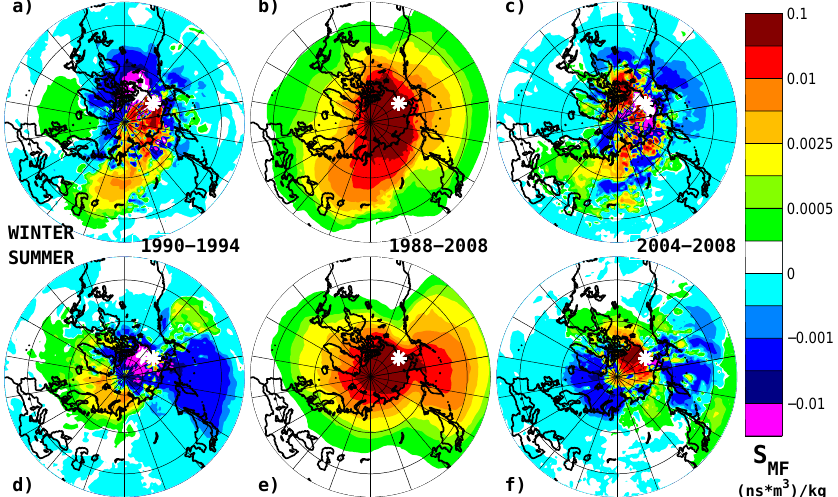
Fig. 3. Transport climatologies ( S MF ) at Barrow during winter (upper row of panels) and summer (lower row). The middle column shows the mean S MF , averaged over the whole time period (1988–2008). The left column of panels illustrates the difference from the mean flow for the early period 1990–1994, and the right column illustrates the difference from the mean for the late period 2004–2008. The station’s location is marked with a white